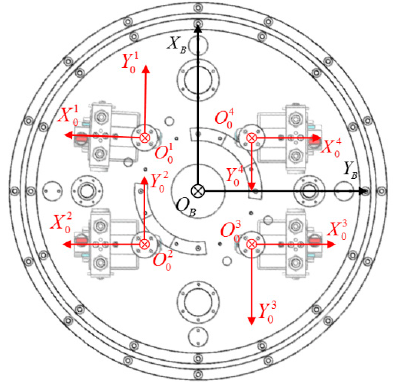
Figure 4. The coordinates of the robot and the legs (top view).